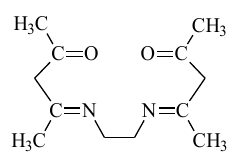
Figure 1. Ethylenodiamino-bis-acetylacetone (EDAB-acac) formula. Cellulose triacetate (CTA), o -nitrophenyl pentyl ether ( o- NPPE), and dichloromethane (Fluka,